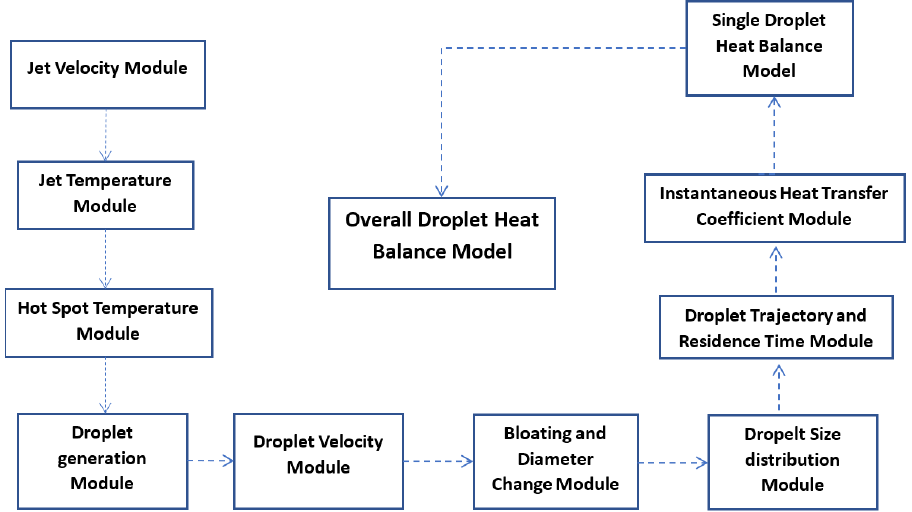
Figure 1. A schematic representation of incorporating modules for developing the global droplet heat transfer model.